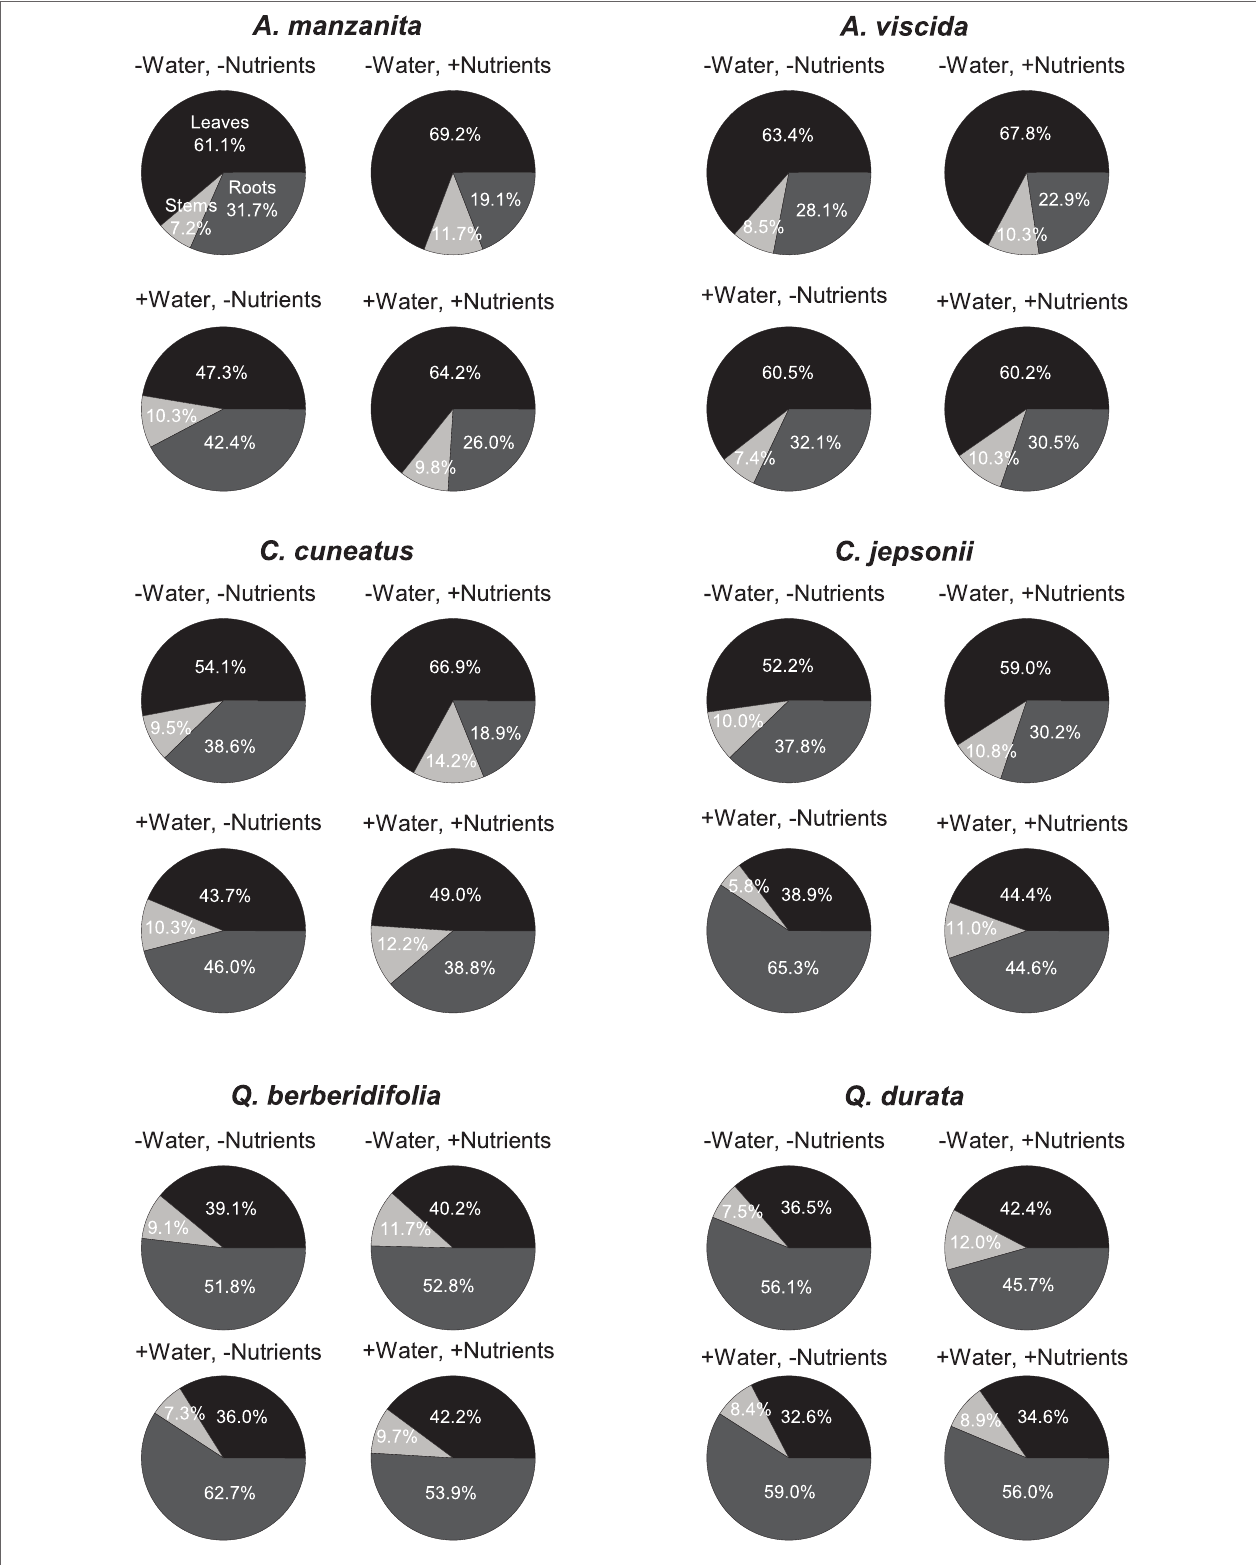
FIGURE 4 | Proportional allocation of N to green leaf (black), stem (light gray), and root (dark gray) N pools. Taxa on left side of figure panel originate from non- serpentine soils, and taxa from the right side of the panel originate from serpentine soils. Data represent mean responses ( n =